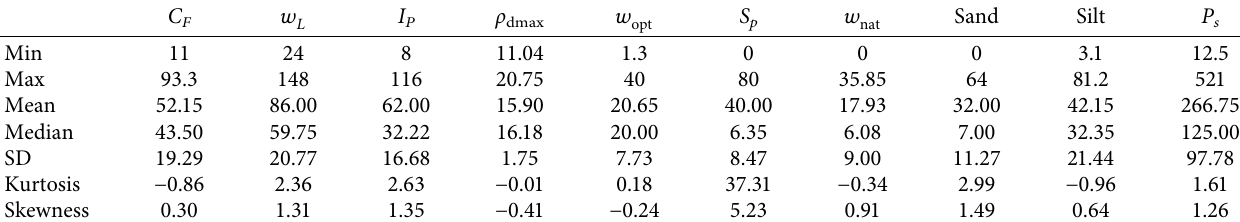
Table 1: Descriptive statistics of various input and output parameters used in GEP and MEP model development. C F